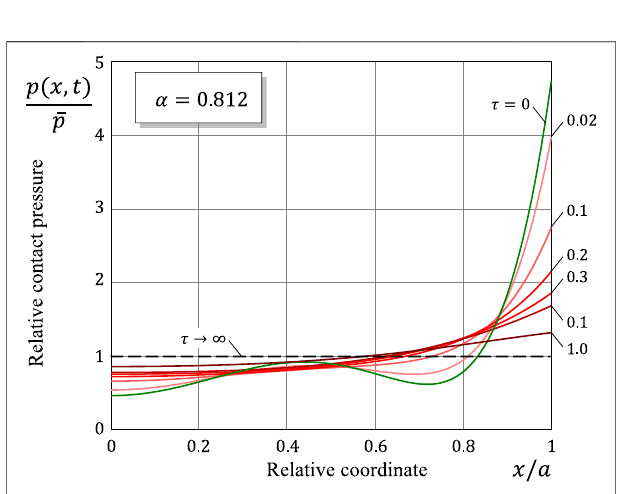
FIGURE 6 | Space-variation of the contact pressure for different values of the relative time variable τ = t / τ in in the sub-Archard wear case.